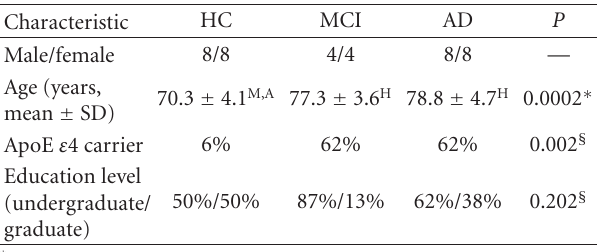
Table 1: Demographic